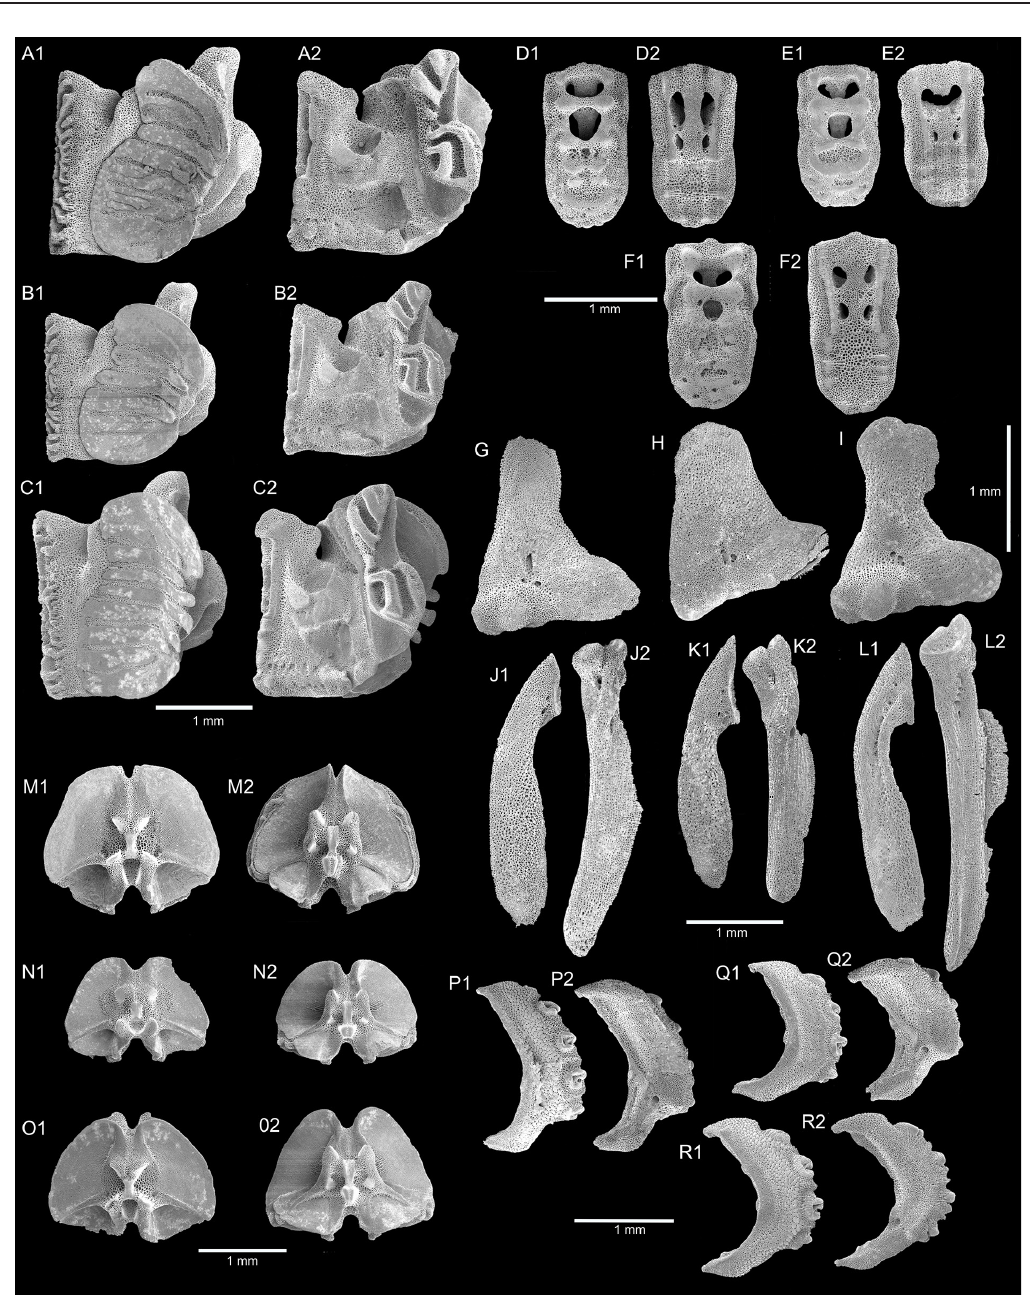
Fig. 5. SEM images of skeletal elements of Ophiocoma ( Breviturma subgen. nov.) brevipes Peters, 1851 (SMNH-133230), O. ( B. ) dentata Müller & Troschel, 1842 (SMNH-133232) and O. krohi sp. nov. paratype (SMNH-Type-8535). A-C . Oral plates, abradial aspect at left, orientated with dorsal side up. A . O. brevipes . B . O. dentata . C . O. krohi sp. nov. D-F . Dental plates, external aspect left, internal aspect right, dorsal edge upwards. D . O. brevipes . E . O. dentata . F . O. krohi sp. nov. G-I. Radial shields, internal aspect, proximal edge upwards. G . O. brevipes . H . O. dentata . I . O. krohi sp. nov. J-L .Vertebrae from proximal part of arm, proximal aspect left, dorsal upwards. J . O. brevipes . K . O. dentata . L . O. krohi sp. nov. M-O . Genital plates, abradial plate left, adradial plate right, distal ends up (towards radial shields). M . O. brevipes . N . O. dentata . O . O. krohi sp. nov. P-R . Lateral arm plates from proximal arm, external aspect left, internal aspect right, distal end right. P . O. brevipes . Q . O. dentata . R . O. krohi sp. nov. For institution codes see main